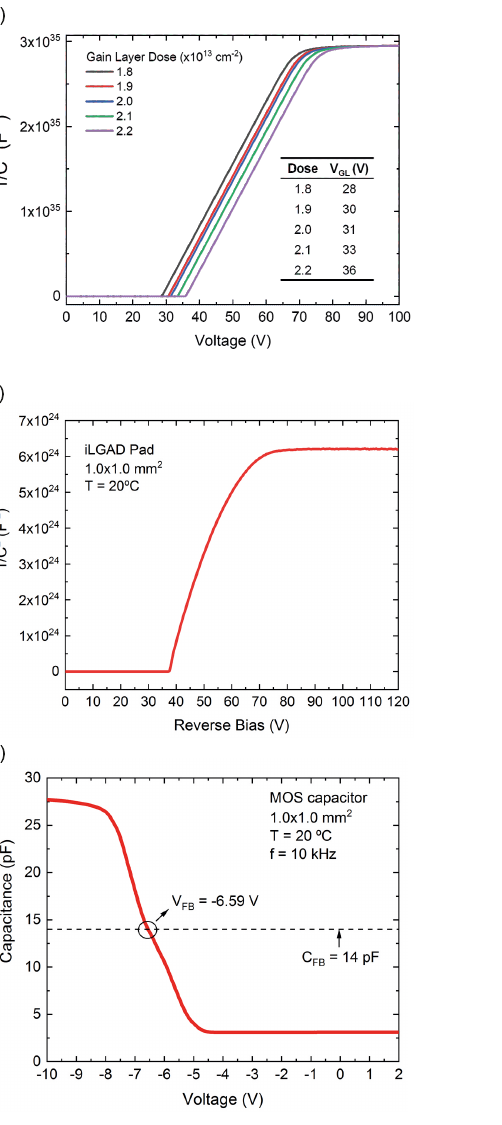
Figure 9. ( a ) C − V simulation for different boron doses. The gain layer increases with increasing boron dose. ( b ) Simulations of the gain for each boron dose. As expected, the gain is increasing with the increase of the boron dose. ( c ) C-V measurement. The gain layer depletion is reached at 38 V. Full depletion voltage is 70 V. ( d ) I-V measurement. Leakage current of 10 nA until the breakdown, which is achieved over 400 V. ( e ) C-V measurement of a MOS capacitor. Flat-band voltage is graphically calculated using the flat-band capacitance value. ( f ) TCT measurement with an IR laser. The gain is calculated as the ratio of the collected charge of an iLGAD and the charge of a pin diode. A linear gain between 12–24 is observed between 70–350